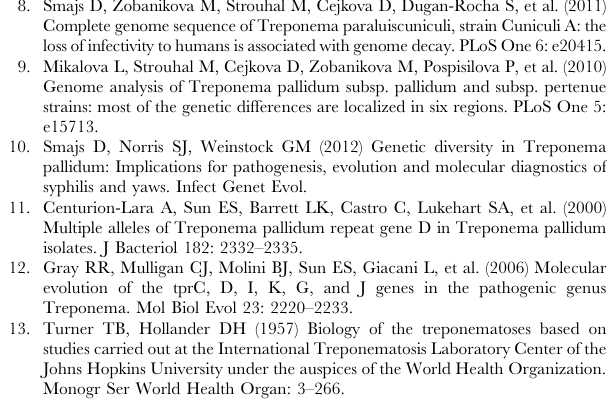
Table S1 List of genes encoding putative virulence factors annotated in the Mexico A genome. Putative virulence factors were defined as those previously described by Cˇ ejkova´ et al. [7] and comprised 31 genes (including tpr , arp , and TPAMA0136 genes).